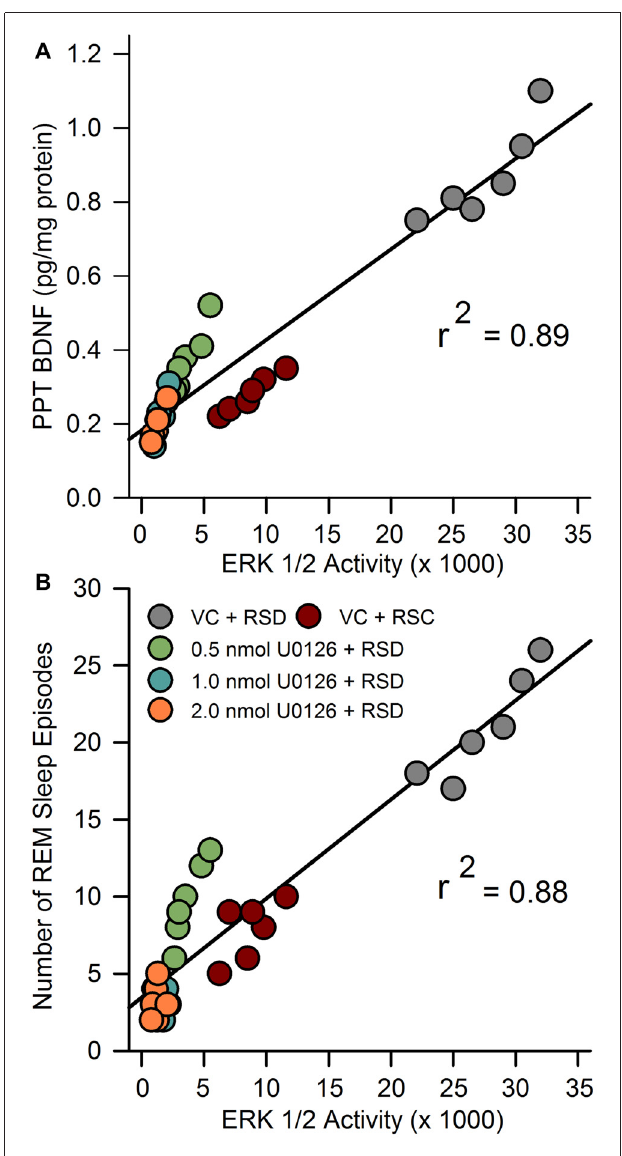
FIGURE 5 | Molecular correlates of RSHD. (A) The relationship between selective REM sleep deprivation (RSD)-induced changes in amount of BDNF protein and ERK1/2 activity in the PPT of rats treated with vehicle control and different concentrations of U0126. Plot of linear regression best fit (solid line) showed a statistically significant positive slope ( R 2 = 0.89; p < 0.001) between ERK1/2 activity and individual animals’ amount of BDNF in the PPT. (B) Relationships between selective RSD-induced changes in RSHD, as measured by number of REM sleep episodes, and changes in ERK1/2 activity in the PPT. Plots of linear regression best fit (solid line; Pearson product-moment correlation) revealed a significant relationship between number of REM sleep episodes and level of ERK1/2 activity in the PPT ( R 2 = 0.88; p < 0.001).